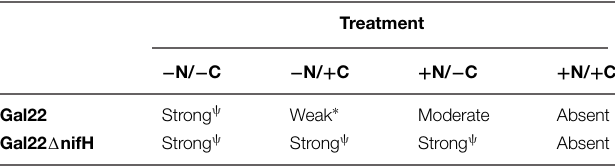
TABLE 4 | Colonization of M. mangrovicola Gal22 on R. mangle roots assayed under different treatments.